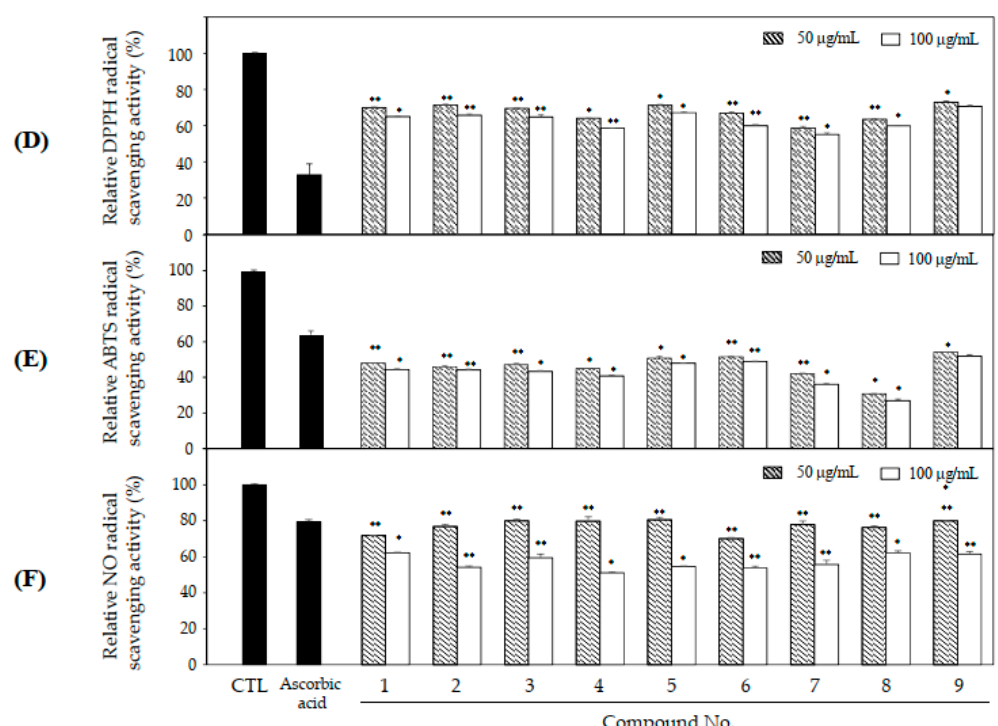
Figure 4. Anti-melanogenesis and anti-oxidant effects of nine compounds isolated from 100 E-OH fraction of S. glabrescens . ( A ) TYR activity, ( B ) melanin content, and ( C ) cytotoxicity in B16F10 cells, ( D ) DPPH and ( E ) ABTS, and ( F ) NO radical scavenging activities. The data are represented as the mean ± SD (n = 3) of three individual experiments. * p < 0.05 and ** p < 0.01 compared with control.